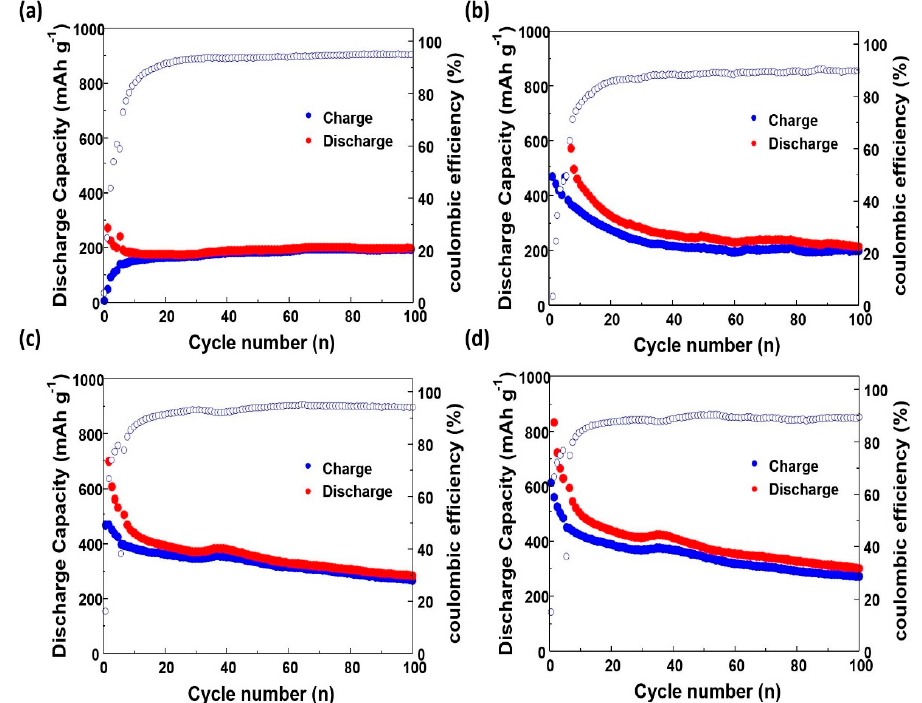
Figure 4. Charge-discharge graph when the bare Cu current-collector and Cu current-collector irradiated with a laser are used as lithium ion batteries. The charge and discharge on the Cu current-collector: ( a ) The bare collector; and the collectors irradiated with a laser of ( b ) 10 W; ( c ) 20 W; and ( d ) 30